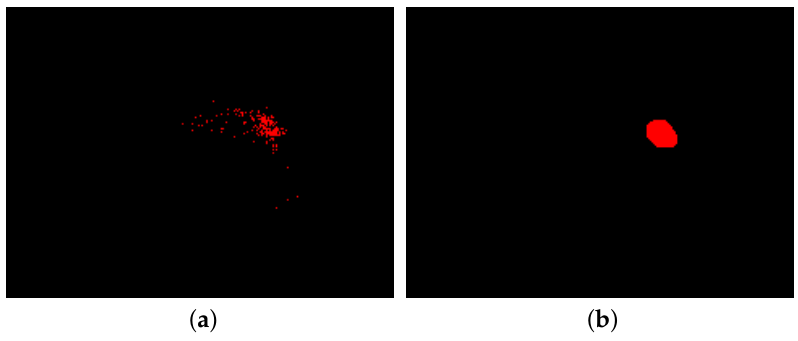
Figure 4. ( a ) negative-polarity events before filtering the noise; ( b ) detected region after filtering the noise.